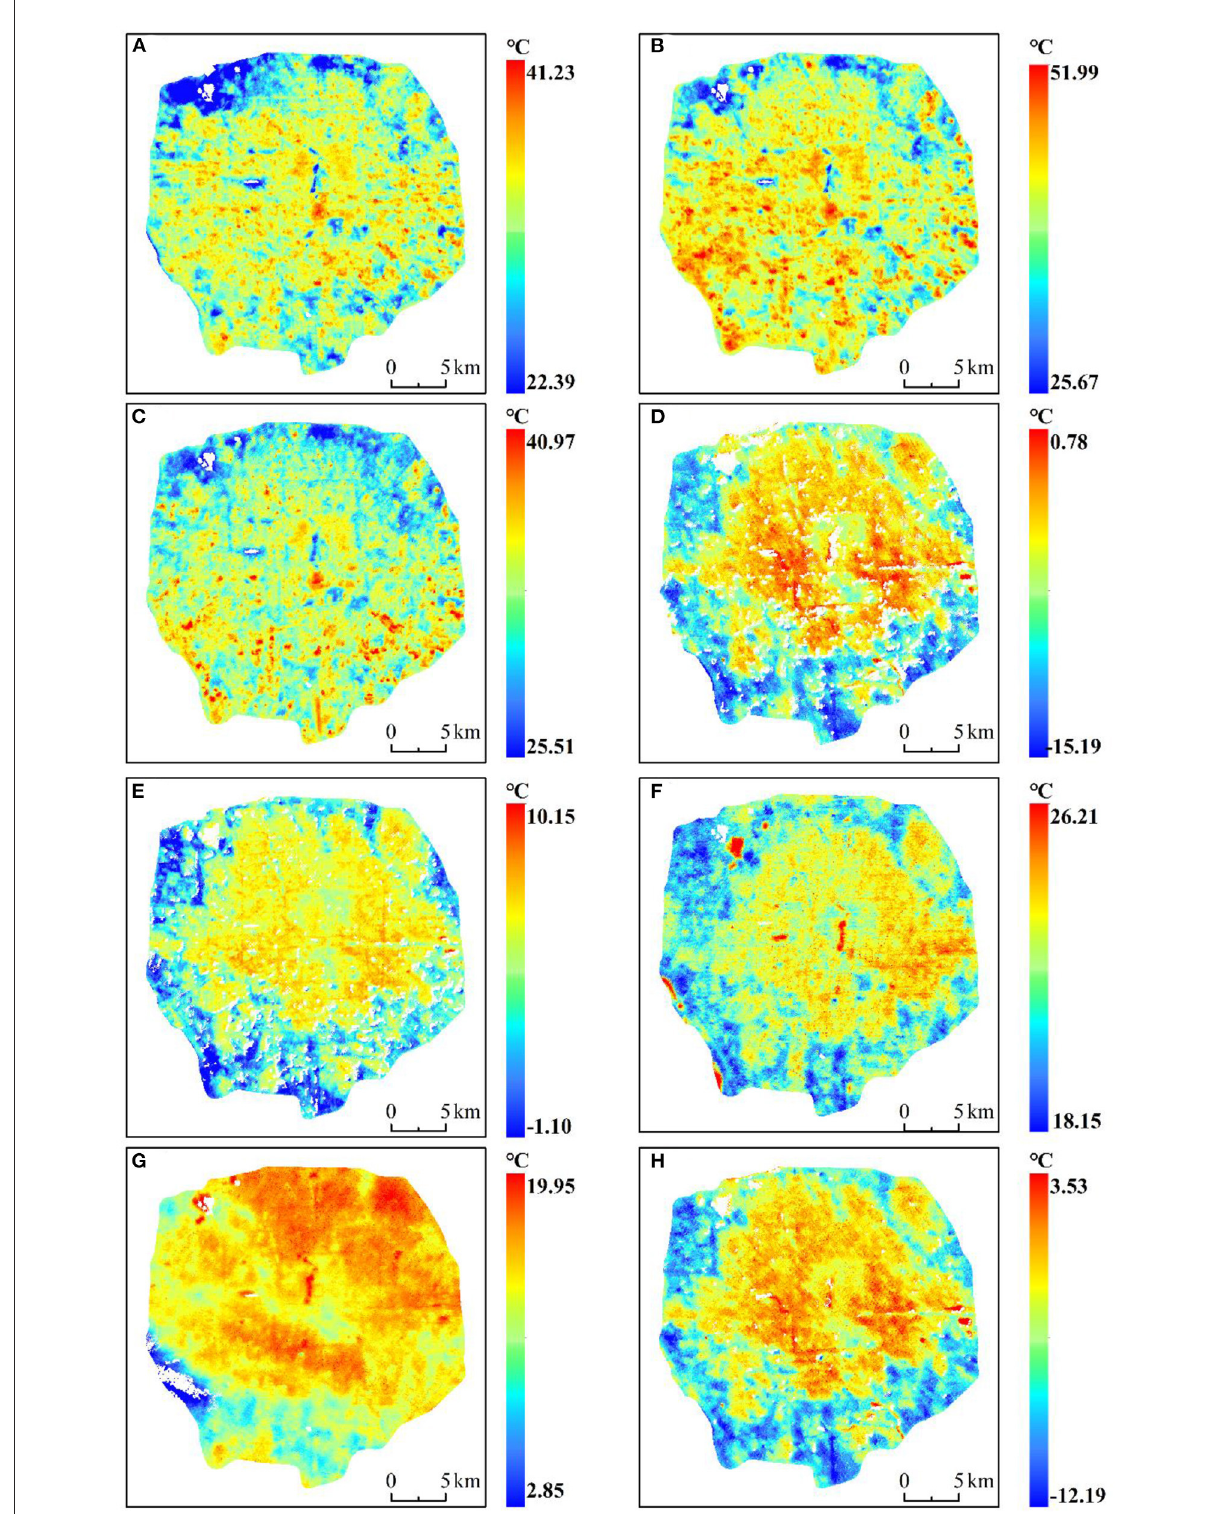
FIGURE4 Diurnal and seasonal land surface temperature (LST) variation in the 5th Ring Area, Beijing, China. (A–D) Daytime LSTs during spring, summer, autumn, and winter, respectively. (E–H) Night-time LSTs during spring, summer, autumn, and winter. All times are in Beijing time (UTC + 8). The white areas in the map indicate missing data (G) and areas with clouds